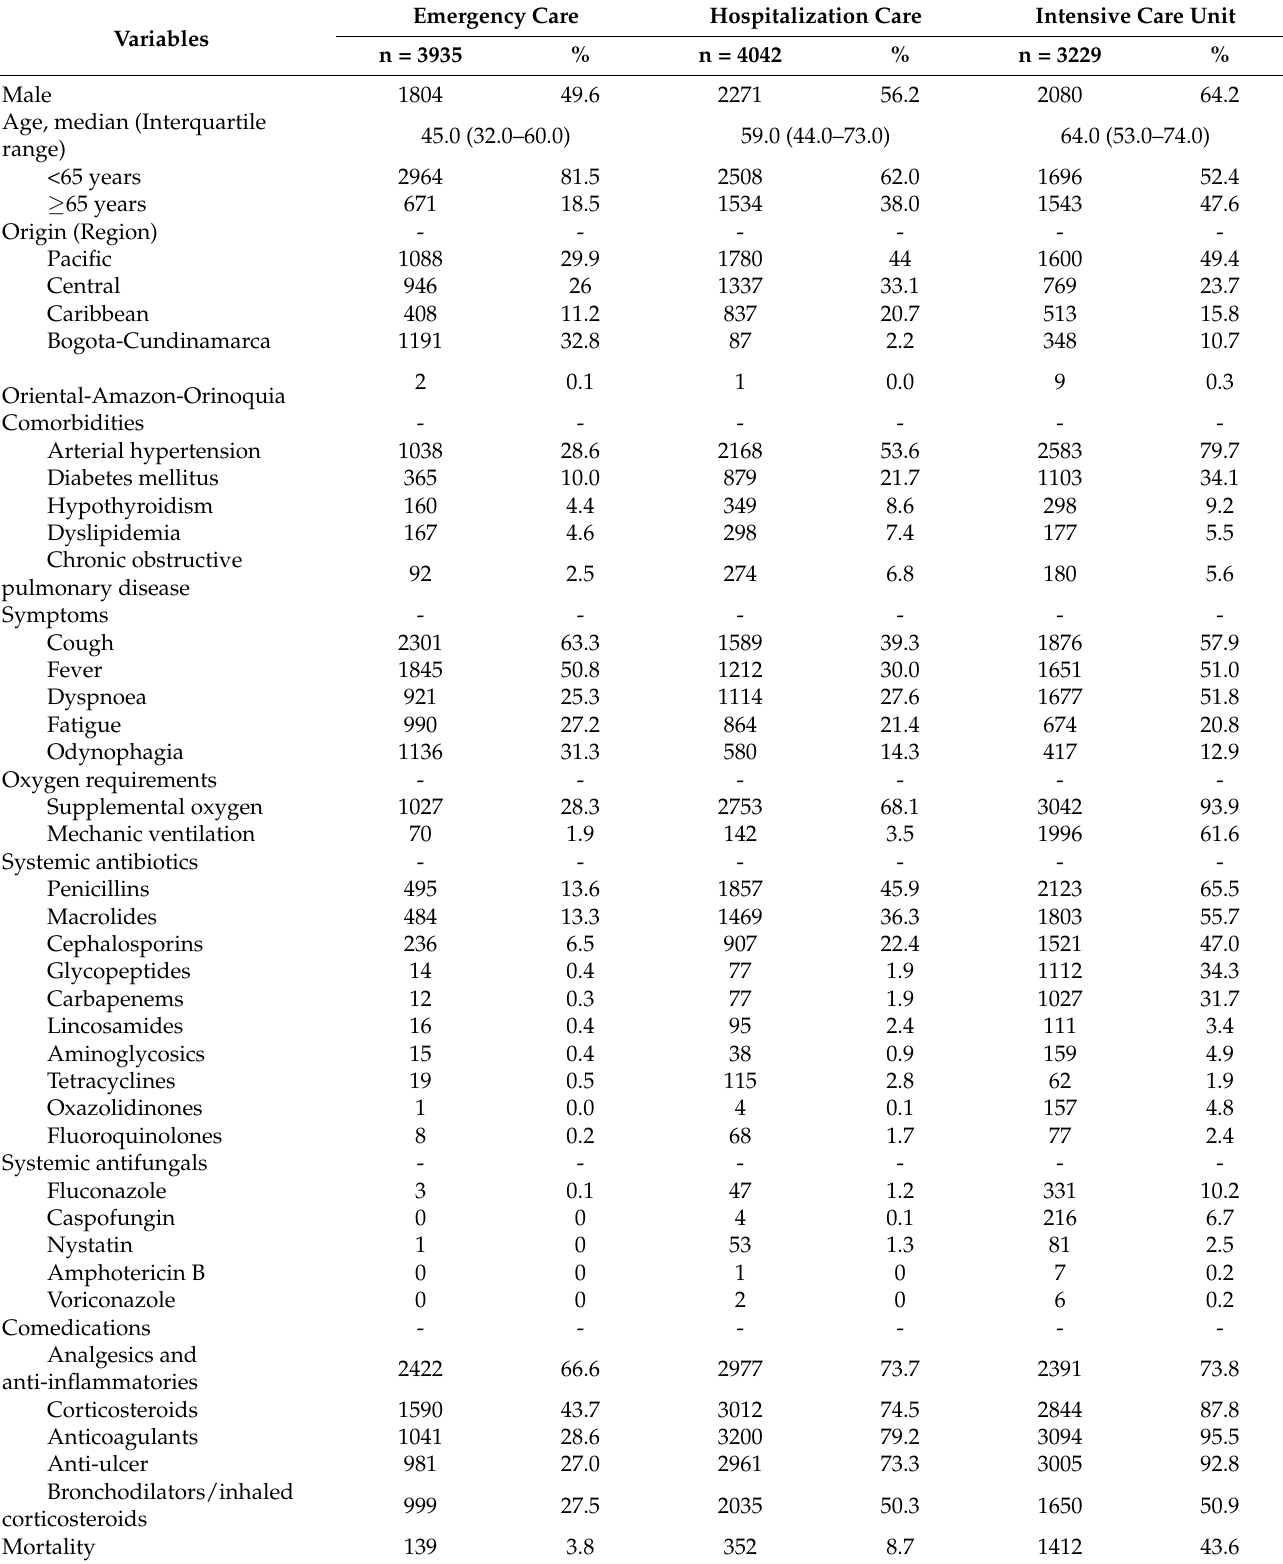
Table 1. Comparison of sociodemographic, clinical, and pharmacological variables of 10,916 patients with a diagnosis of COVID-19 by the care service in eight highly complex clinics in